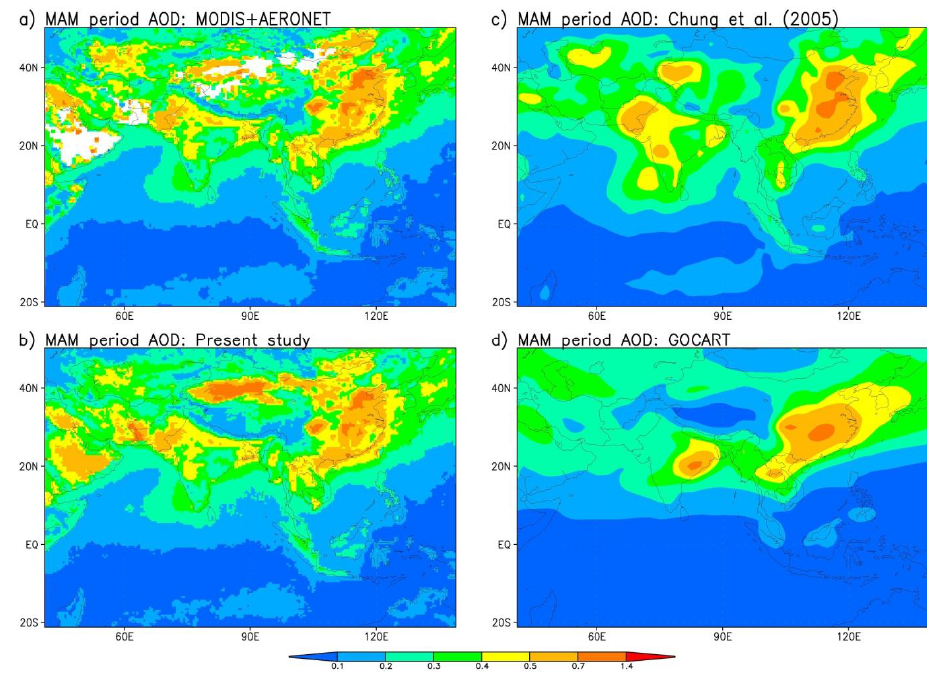
Fig. 3. Total (natural + anthropogenic) AOD simulation in comparison with that in Chung et al. (2005) and the GOCART AOD simulation (on 2.5 ◦ × 2 ◦ ). AERONET/MODIS integrated AODs are also shown (a) . Note that our simulation is 2001–2004 mean while Chung et al. (2005) calculation was for 2001–2003 and the GOCART simulation is averaged from 2000 to 2002.